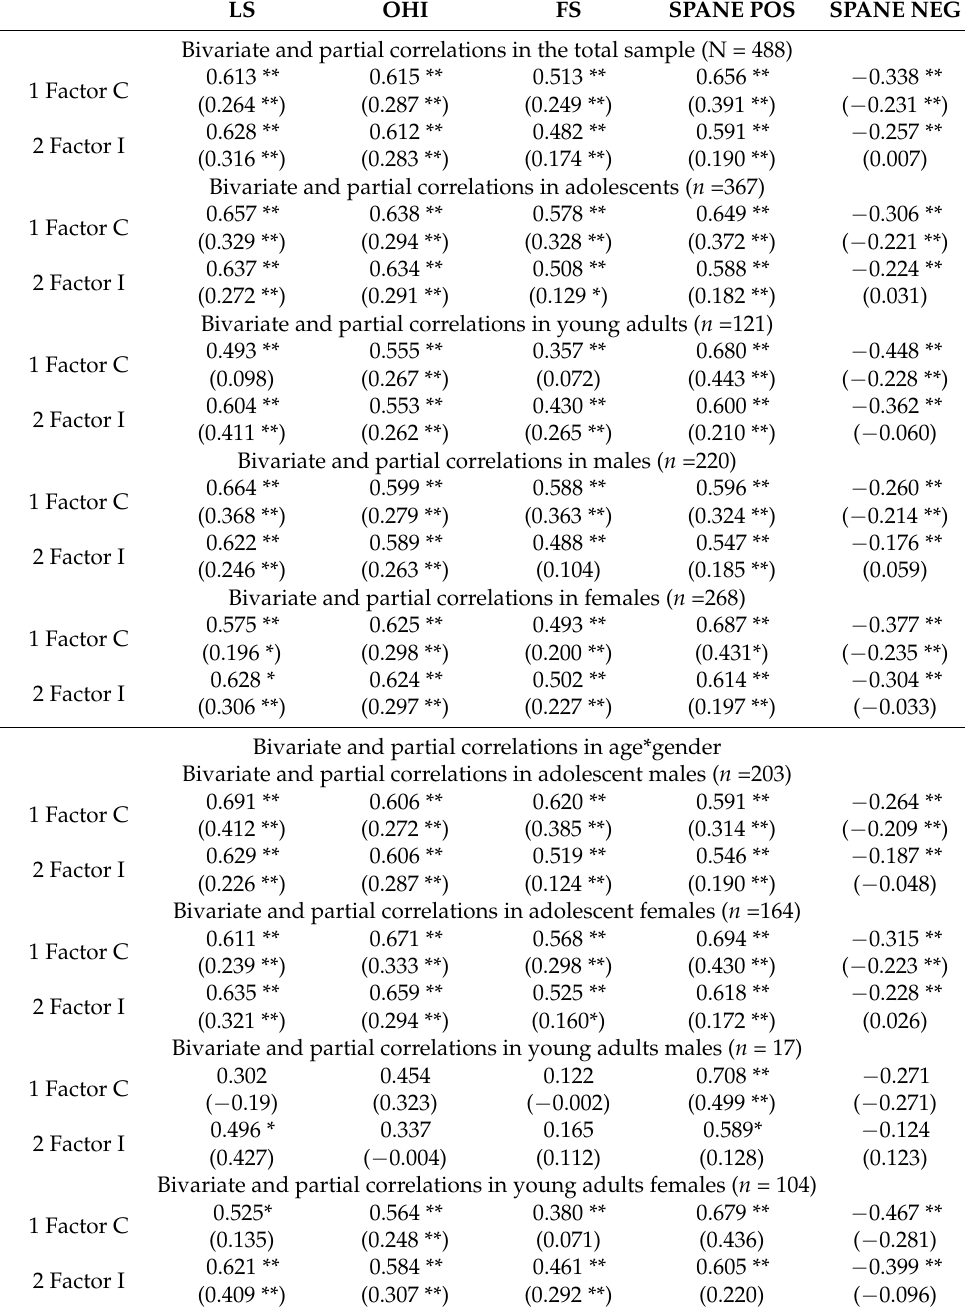
Table 7. Zero-order and partial correlations of the two factors, Contentment and Inner-peace, with well-being and happiness measures in Sample